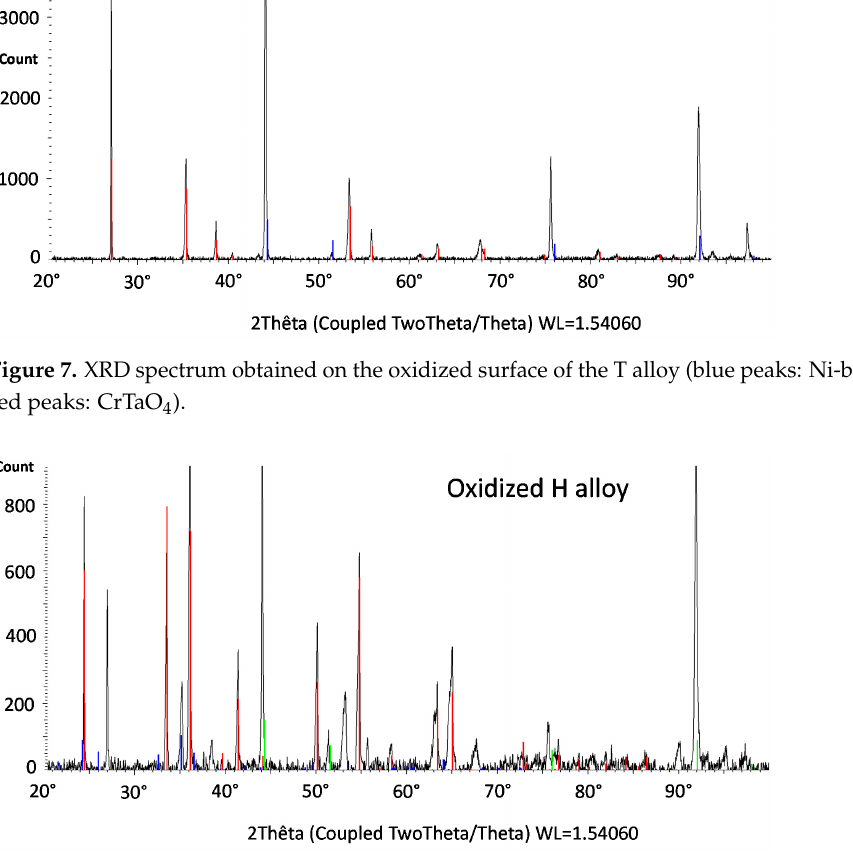
FIGURE 8 Figure 8. XRD spectrum obtained on the oxidized surface of the H alloy (green peaks: Ni-based matrix, blue peaks: NiCr 2 O 4 spinel oxide, red peaks: Cr 2 O 3 ).